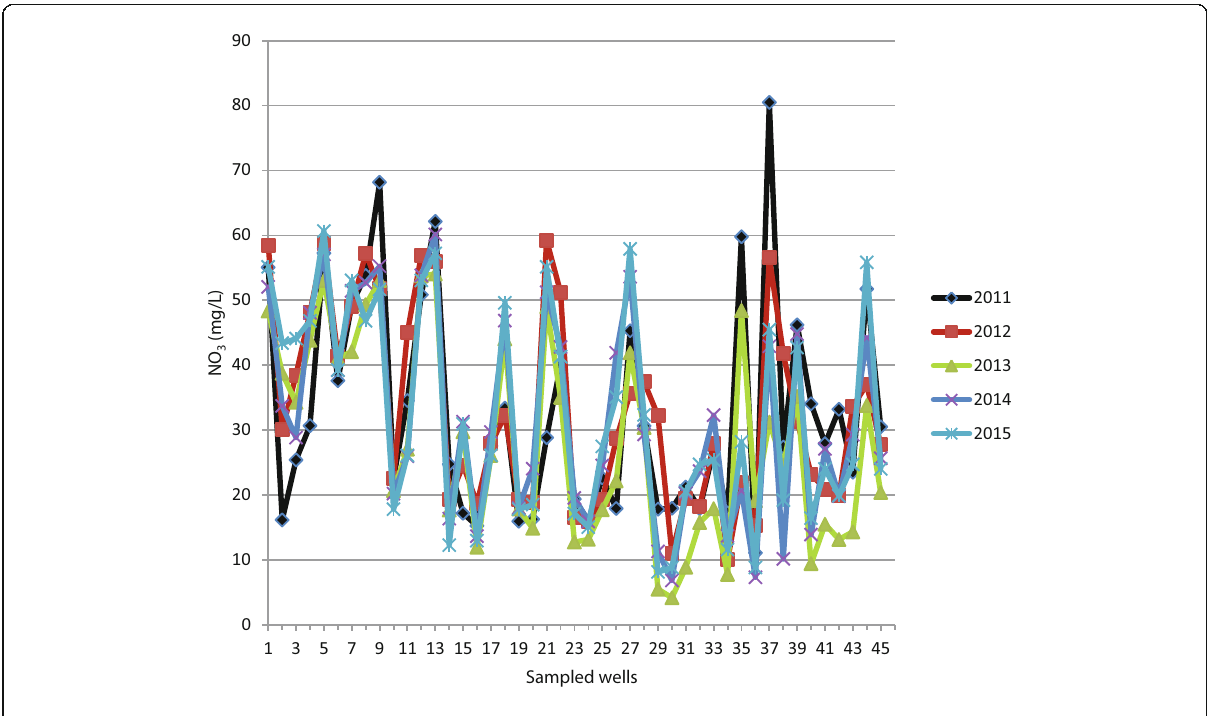
Fig. 3 Average NO 3 concentrations in the sampled